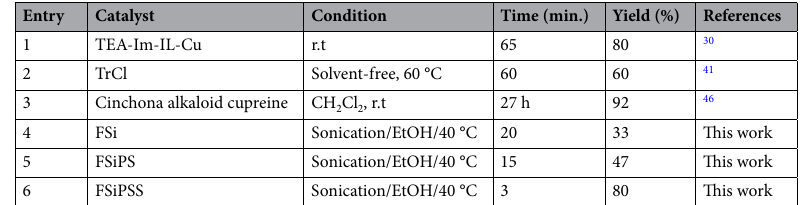
Table 4. Study of the effect of ultrasonication and the role of each part of the catalyst in the reaction.